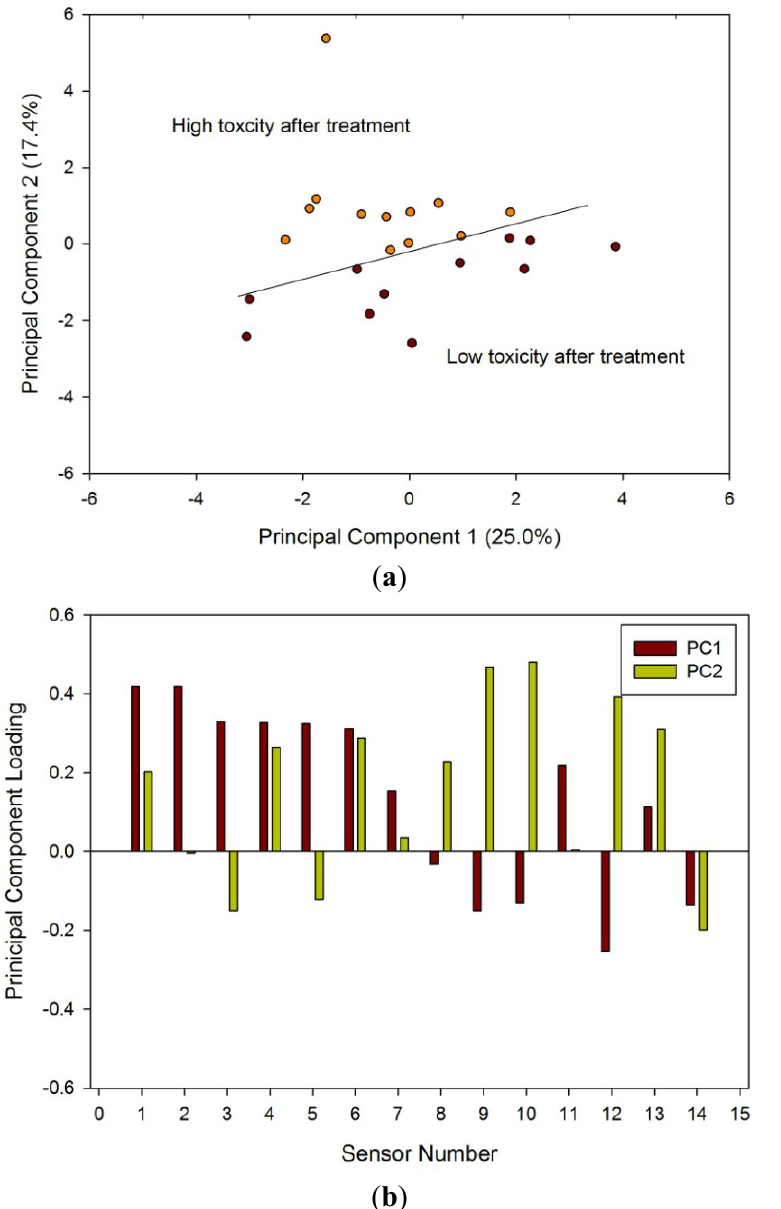
Figure 6. ( a ) PCA results from e-nose data and ( b ) loadings for samples taken before treatment; categorized on their post-treatment toxicity referenced to Table